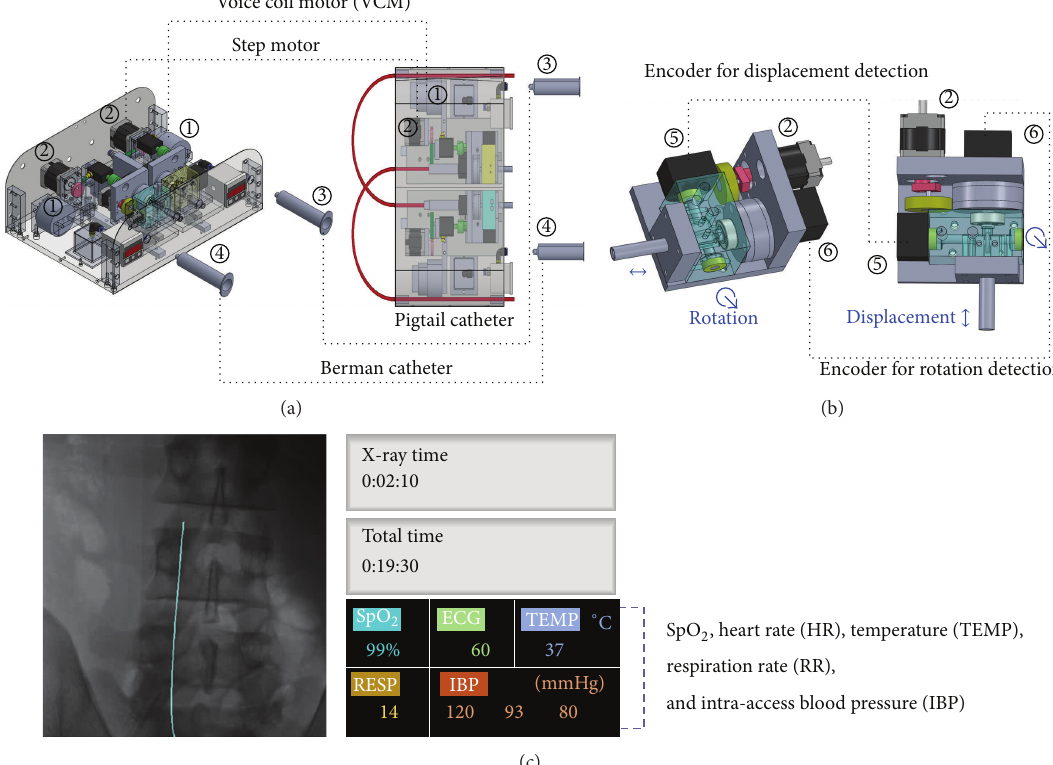
Figure 2: VR simulator system: (a) haptic force and friction force producer for force feedback, (b) rotation and displacement detector for visual feedback, and (c) human-machine